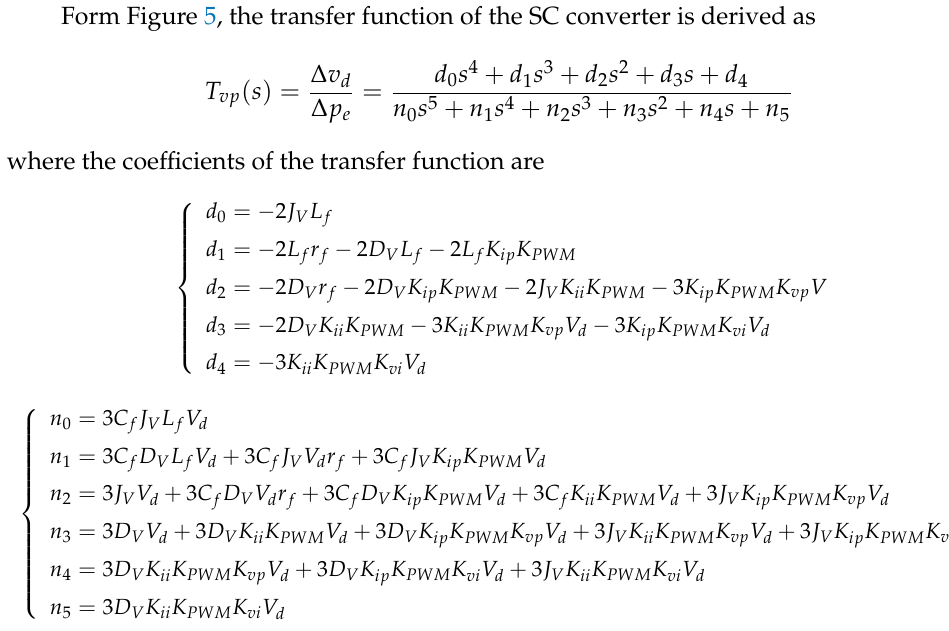
Figure 5. The small-signal model of the SC converter control system.